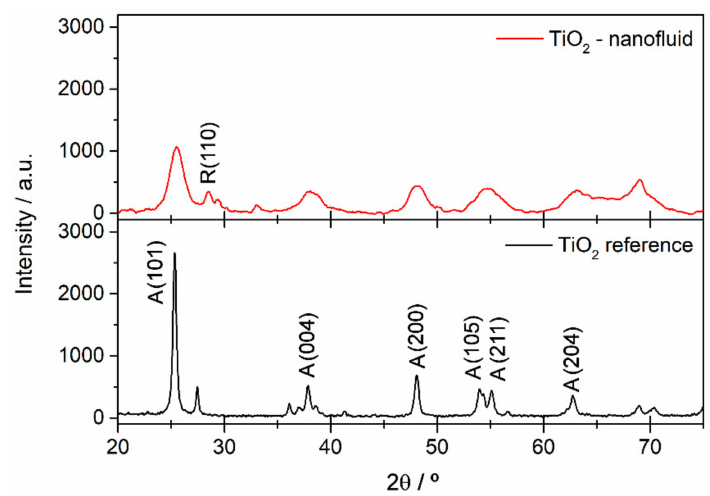
Figure 1. X-ray Diffraction (XRD) patterns for TiO 2 synthesized and commercial TiO 2 nanoparticles used as a reference.